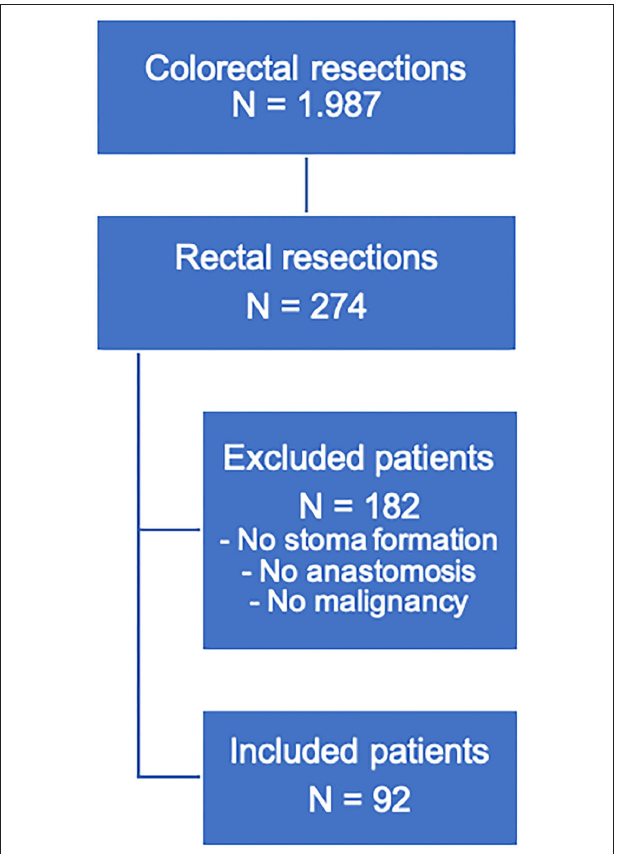
FIGURE 1 | Flowchart for the selection of patients with rectal resections in this study. Patients with rectal resections for benign lesions, abdominoperineal extirpation, or no stoma formation (due to preoperative stoma or upper rectal resection) were excluded.